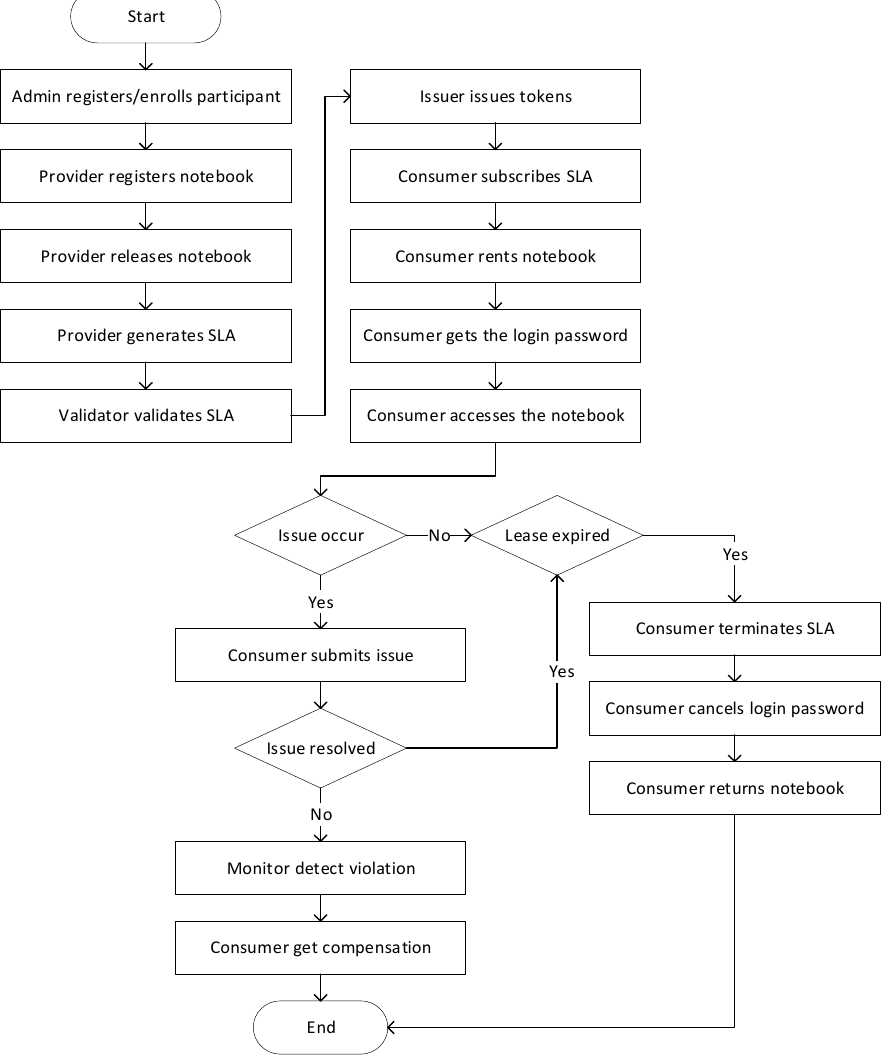
Figure 11. The simplified workflow of the notebook sharing case study.